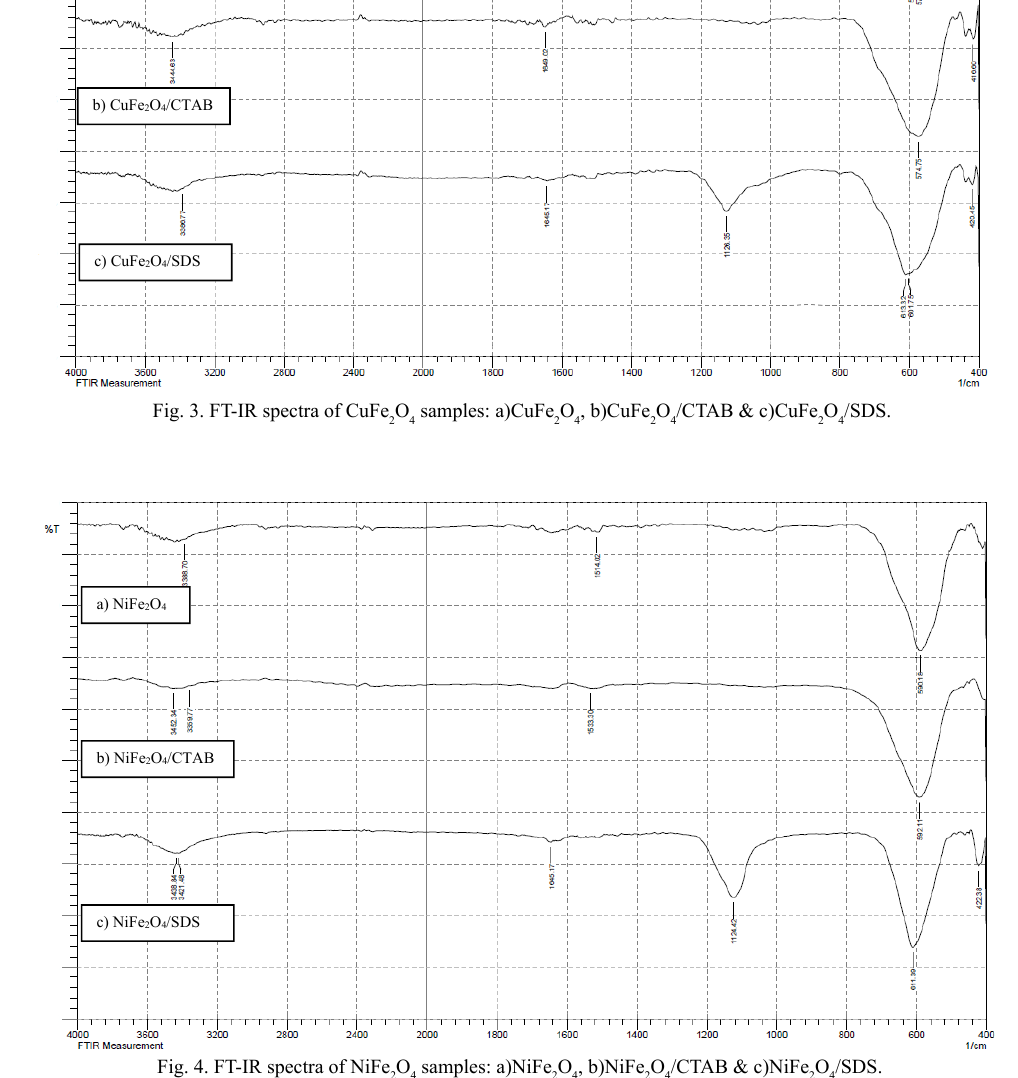
O samples: a)NiFe 2 4